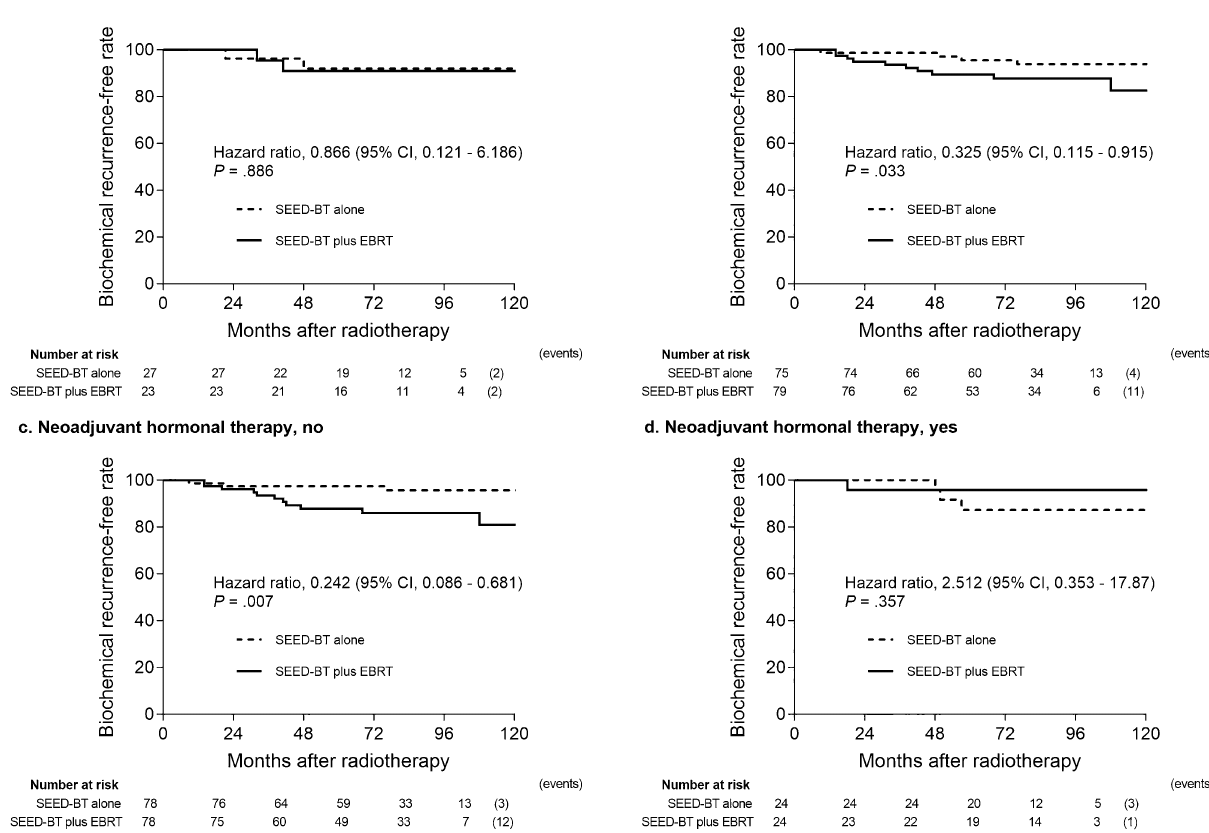
Figure 3. Subgroup analysis of the biochemical recurrence-free rate after propensity score-matching for patients treated with seed brachytherapy (SEED-BT) alone and with SEED-BT plus external-beam radiotherapy (EBRT). ( a ) Favorable intermediate risk subgroup. ( b ) Unfavorable intermediate risk subgroup. ( c ) Subgroup that received no concomitant neoadjuvant hormonal therapy. ( d ) Subgroup that received concomitant neoadjuvant hormonal therapy. CI = confidence